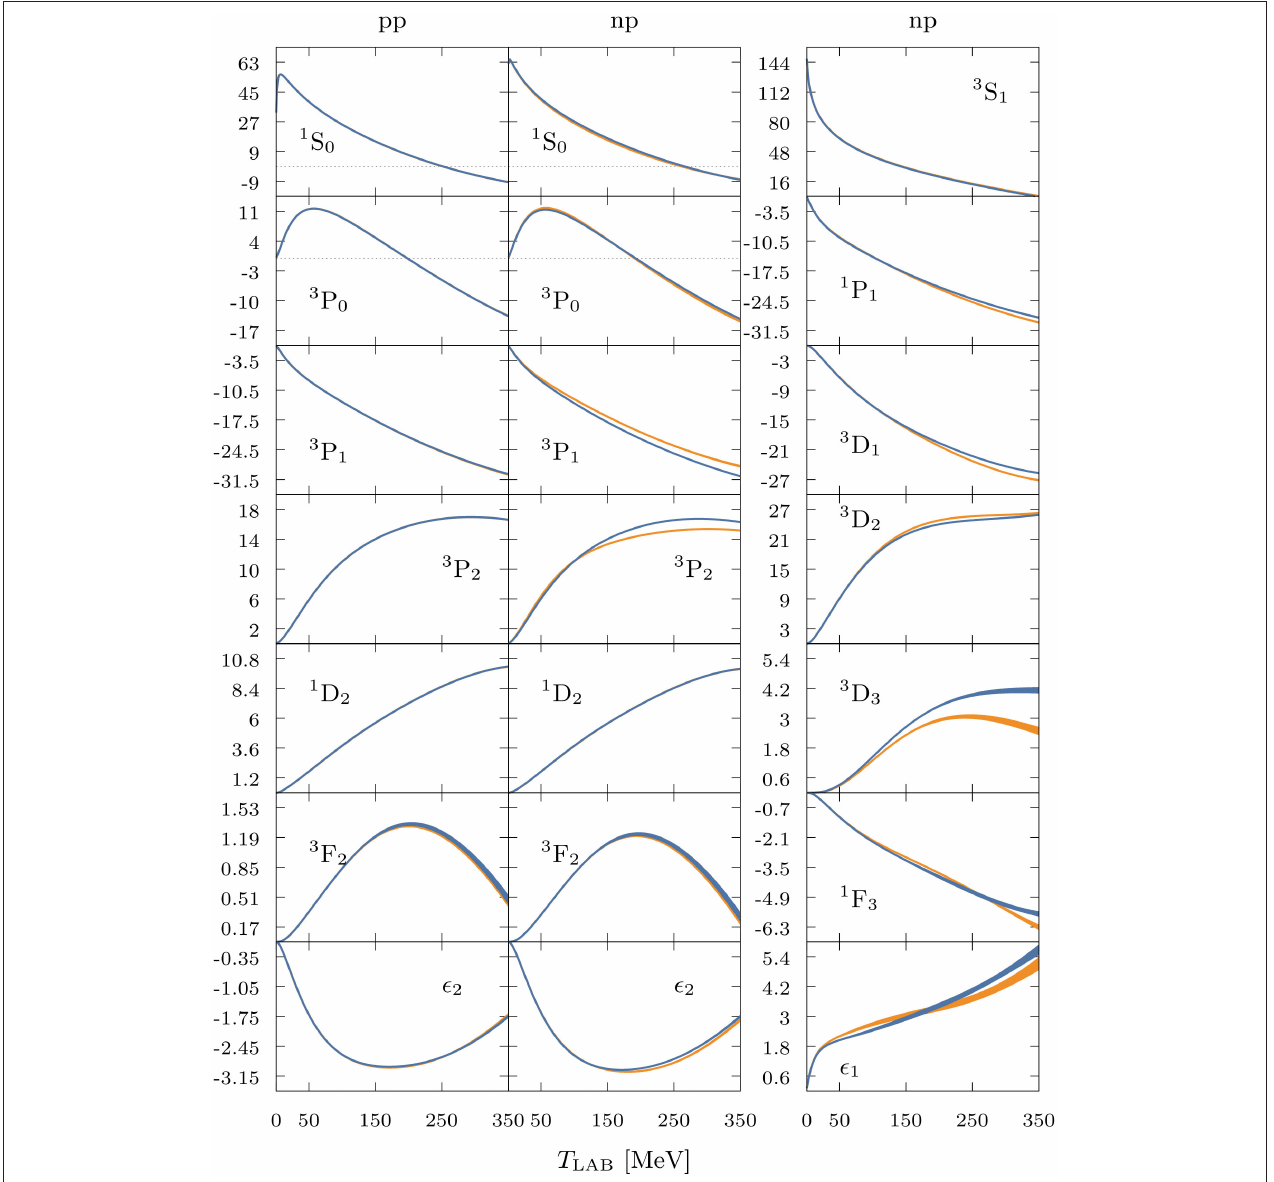
FIGURE 1 | (Color online) Phase shifts obtained from a partial waves analysis to pp and np data and statistical uncertainties. Blue band from Navarro Pérez et al. [42] from a fit with fixed f 2 and orange band [60] from a fit with charge symmetry breaking on the 3 P 0 , 3 P 1 , and 3 P 2 partial waves and in the coupling constants f 2 0 , f 2 p , and f 2 c